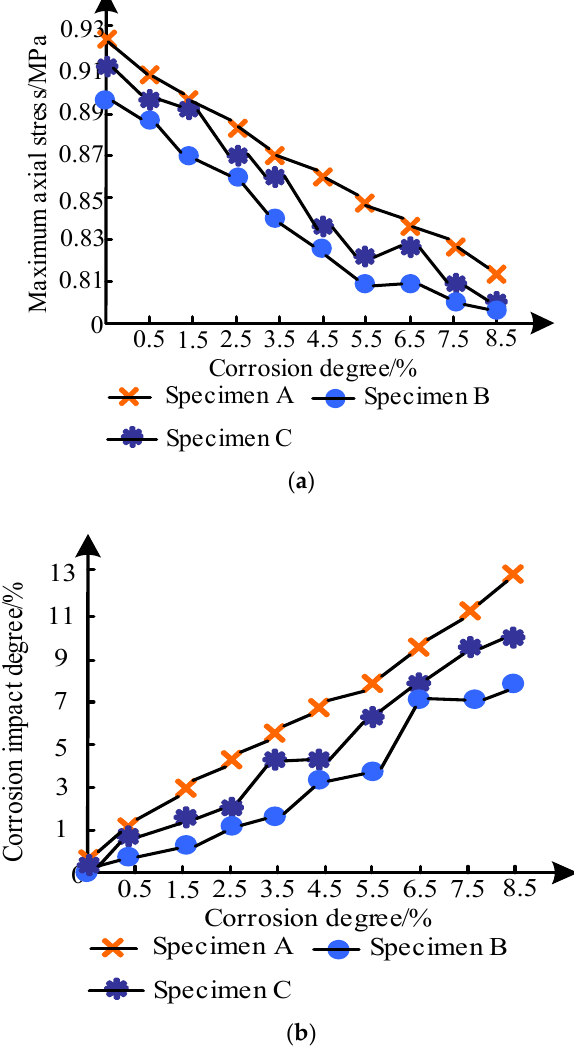
Figure 7. Influence of different corrosion degrees on bolt. ( a ) Influence of different corrosion degrees on the maximum axial stress on the prestressed anchor bolt. ( b ) Influence of different corrosion degrees on bolt corrosion.